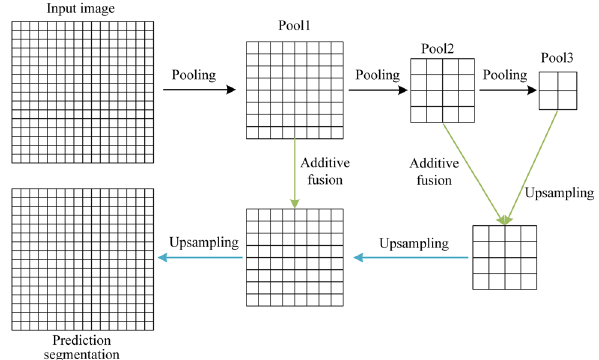
Fig. 2 The shortcut-connection structure of